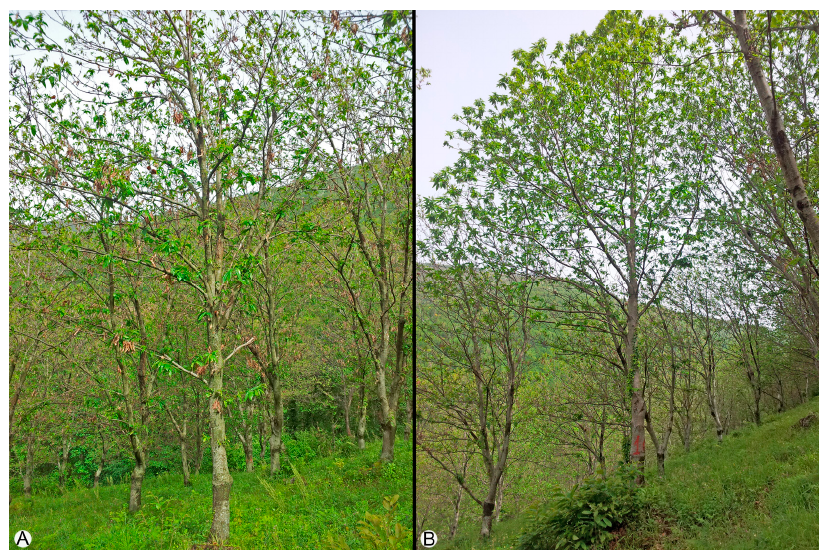
Figure 1. Chestnut trees in Roccarainola study site: ( A ) susceptible tree; ( B ) resistant tree (marked with red paint) among susceptible trees (unmarked).